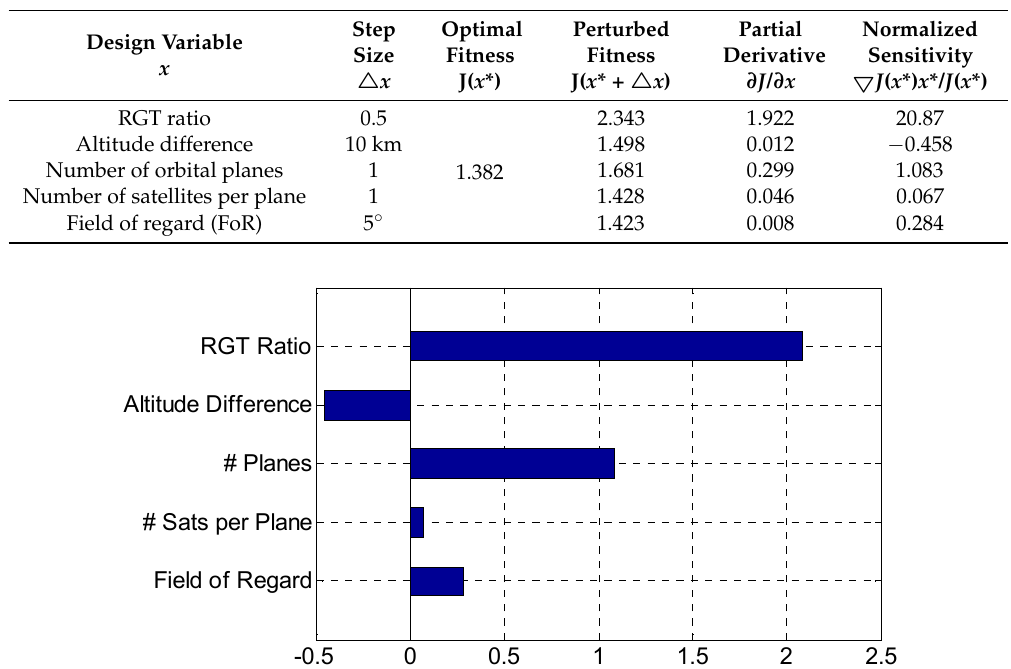
Figure 17. Normalized sensitivity of design variables (RGT ratio divided by 10).